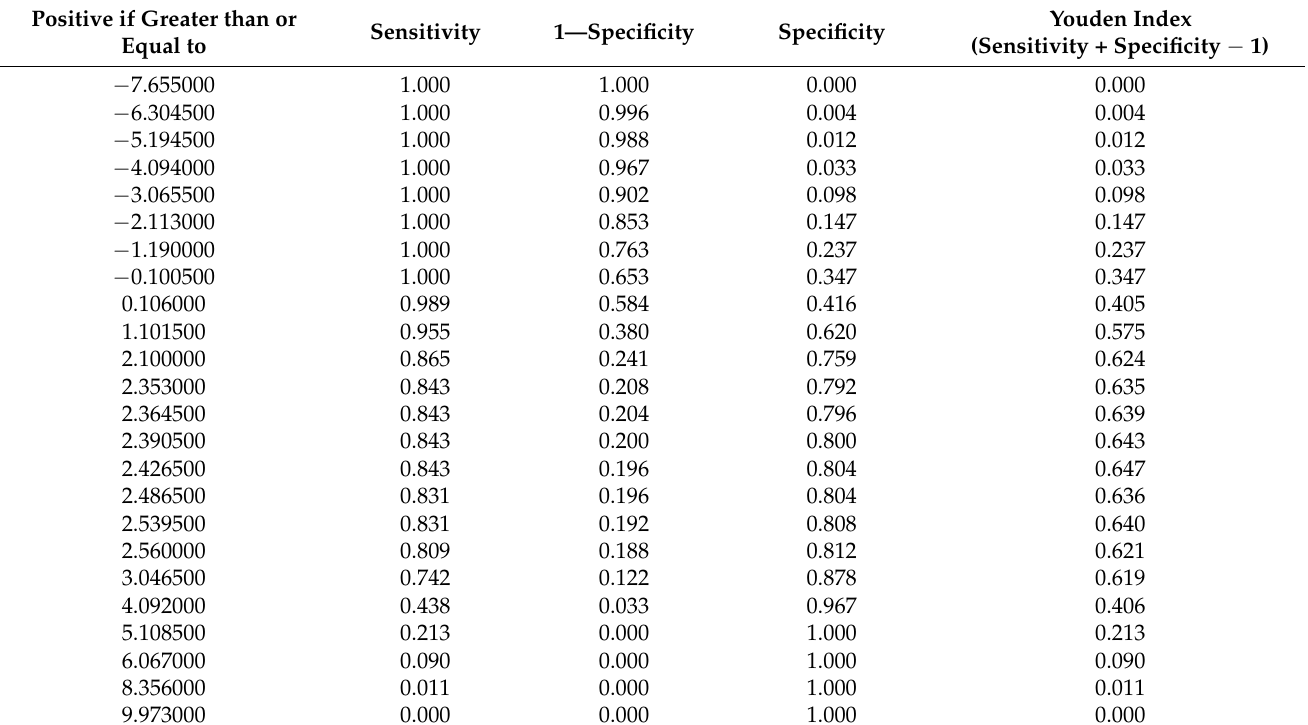
Figure 2. ROC curves calculating the best-fit number of genes in predicting multiple aerodigestive tract cancer in oral cancer patients. Table 4. The best number of factors predicting the development of multiple aerodigestive tract cancers.